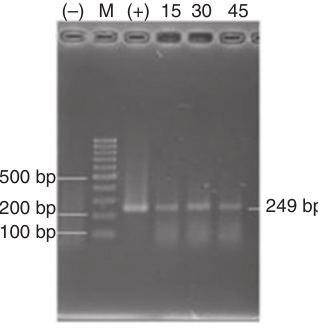
Figure 1: Coupling reaction time optimization. (–); M; ( + ): negative control, 100-bp marker, and positive control. 45 min with EDC added each 15 min during the course of the reaction.